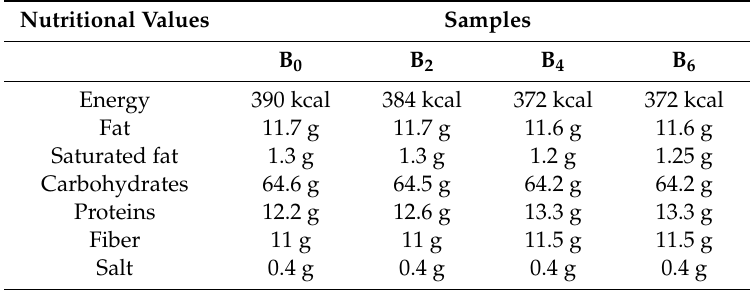
Table 1. Nutritional values (g per 100 g dry weight) and energy content (kcal per 100 g) of the developed